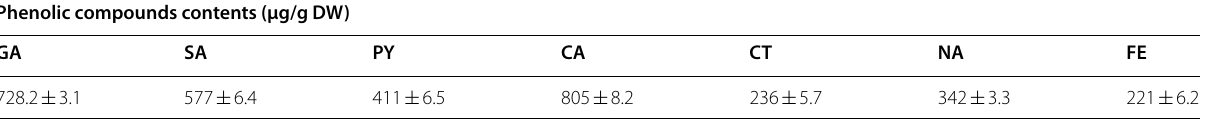
GA gallic acid, SA salicylic acid, PY pyrogallol, CA cinnamic acid, CT catechin, NA naringin, FE ferulic acid. The analyses were performed in triplicates